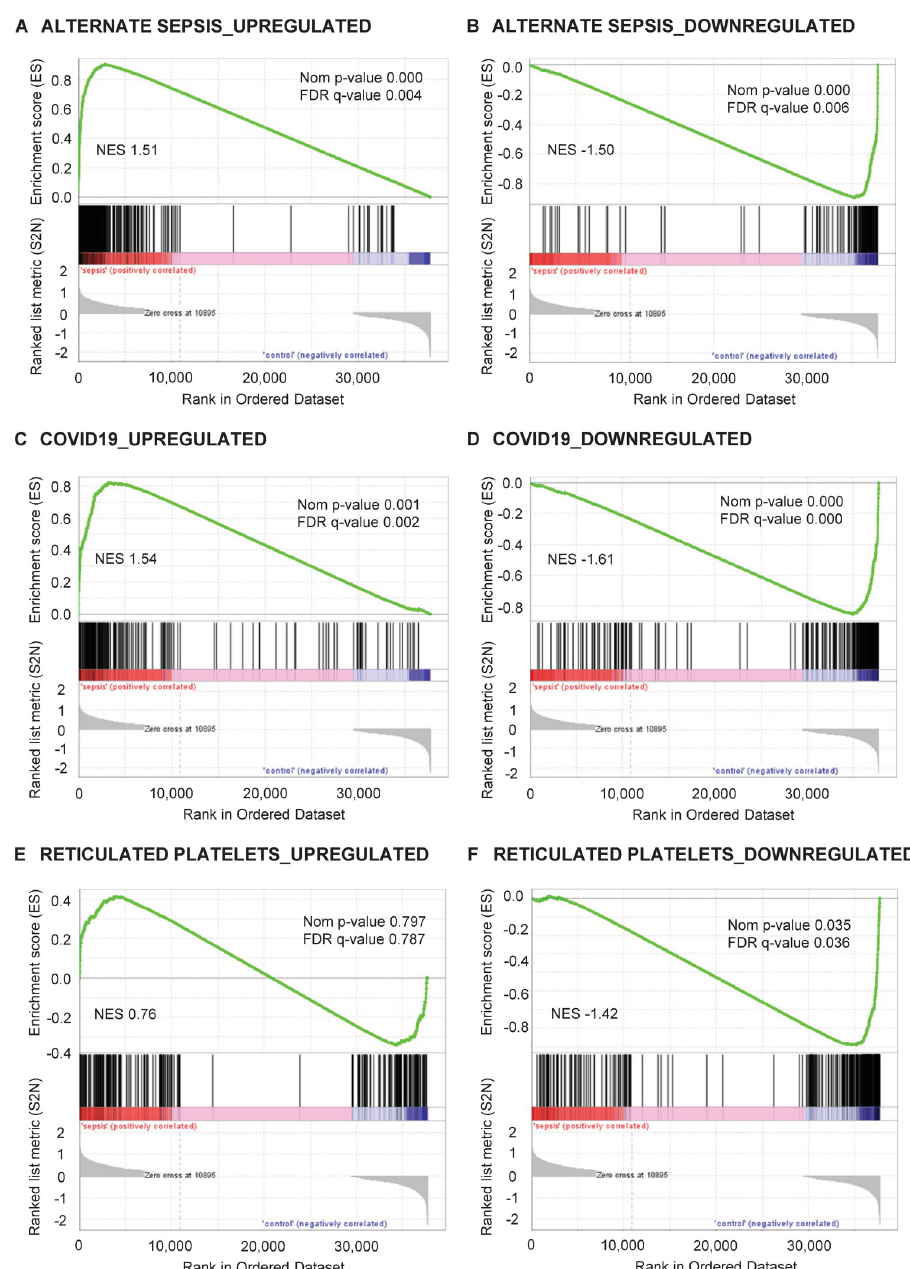
Fig 8. Gene expression in platelets from patients with sepsis and control patients is compared with platelet transcriptome changes in other patients with sepsis, patients with COVID-19 and reticulated platelets by Gene Set Enrichment Analysis. Gene Set Enrichment Analysis with gene sets of differentially expressed genes from published platelet RNA-Seq data [9, 11, 25]. (A) Genes upregulated in sepsis, (B) genes downregulated in sepsis. (C) Genes upregulated in COVID-19, (D) genes downregulated in COVID-19. (E) Genes upregulated in reticulated platelets, (F) genes downregulated in reticulated platelets. The normalised enrichment score (NES) represents the primary metric since it allows comparison between gene sets by taking the gene set size and correlations between the expression data and the gene sets into account [24]. Nom = Nominal, FDR = False Discovery Rate-adjusted.